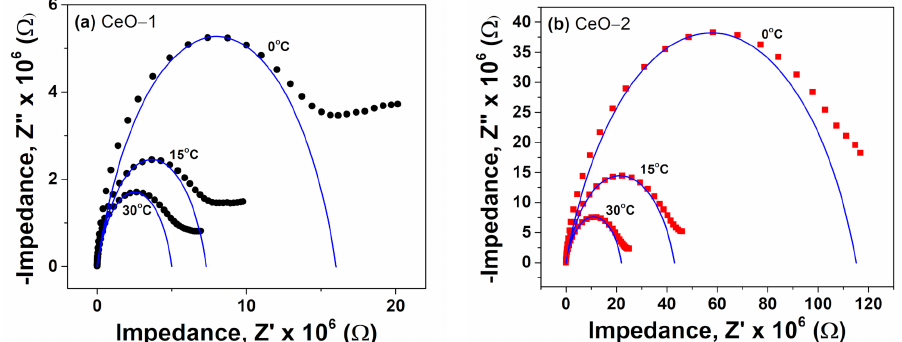
Figure 10. Experimental dielectric data and simulated Cole-Cole plots at various temperatures for ( a ) CeO-1 and ( b ) CeO-2.